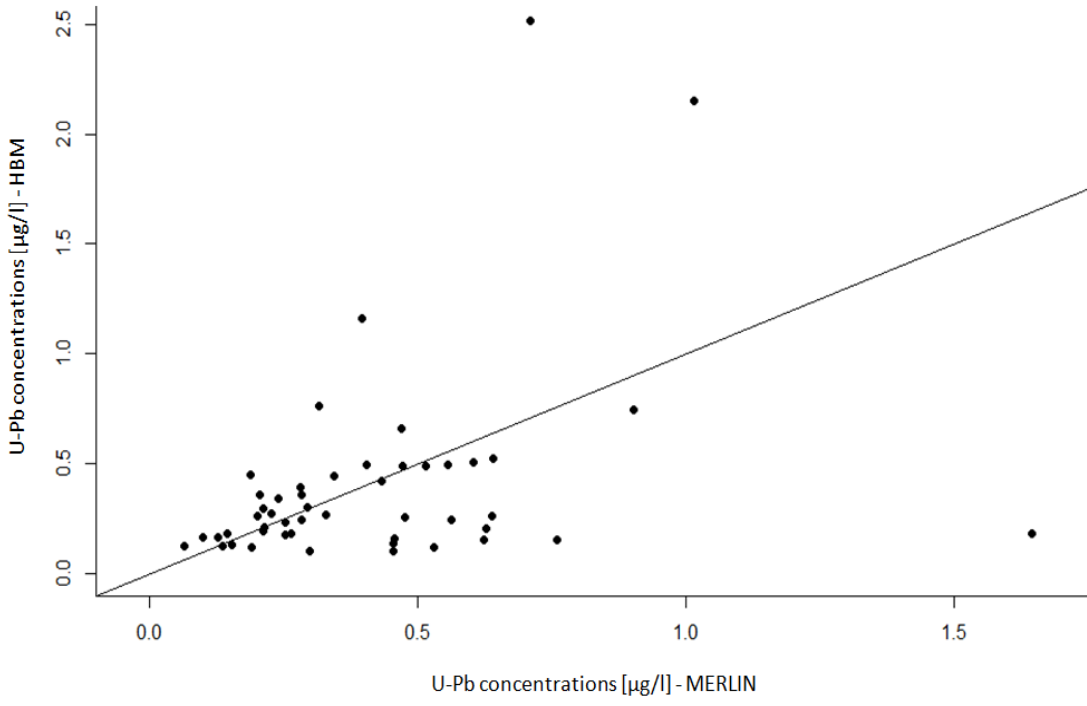
Figure 8. Correlation between urinary lead (U-Pb) concentrations ( µ g / L) estimated by MERLIN software and measured concentrations ( µ g / L) reported in the HBM study.